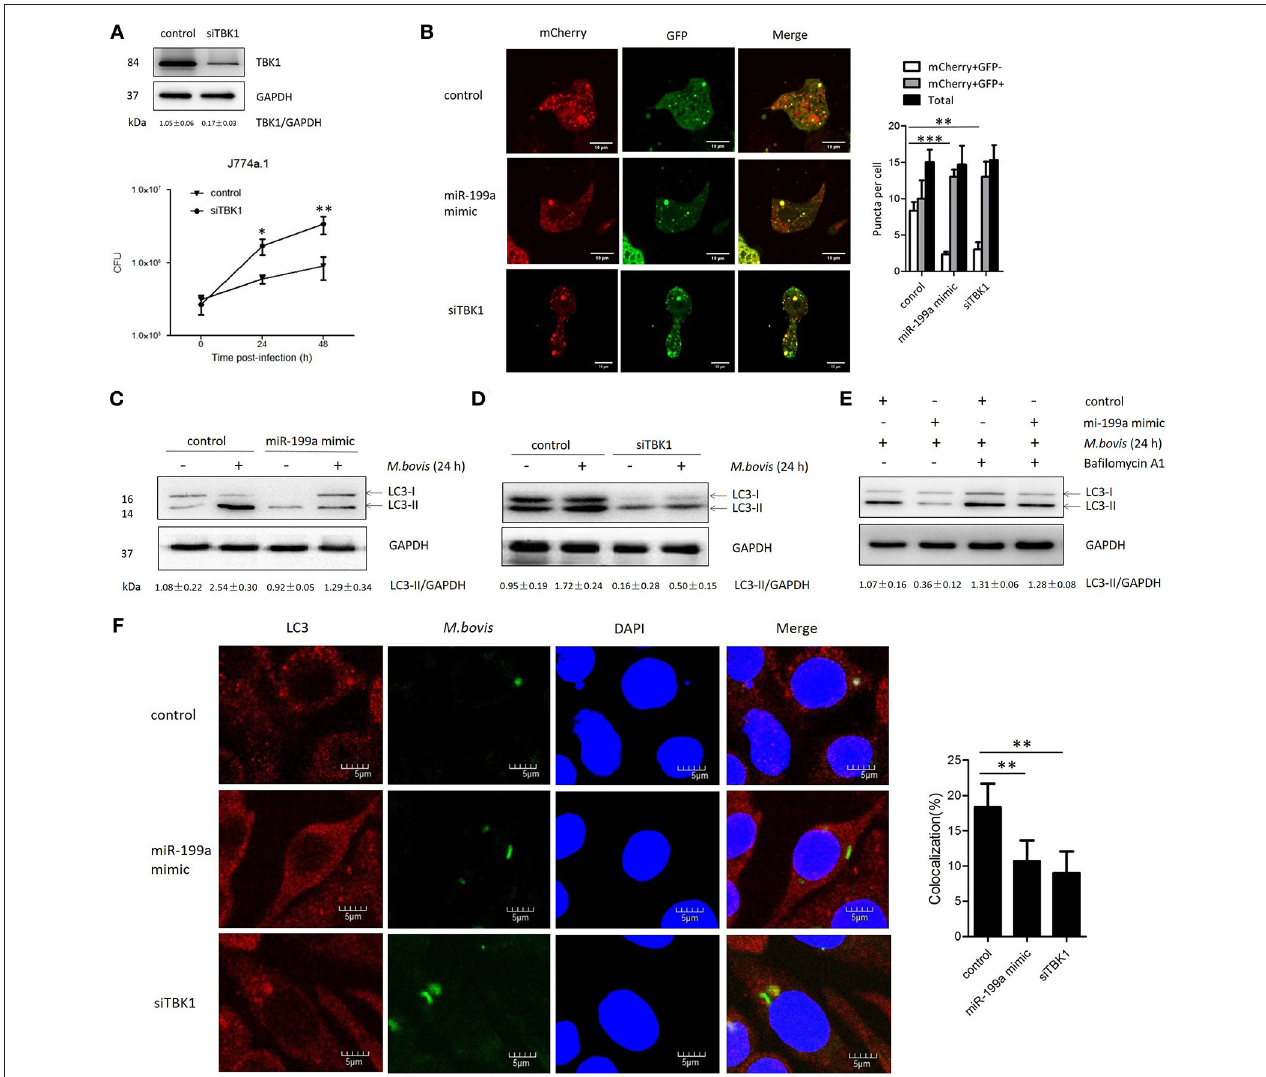
FIGURE 3 | miR-199a suppresses autophagosomes maturation by target TANK-binding kinase 1 (TBK1). (A) Interference efficiency of TBK1 by small interference RNA (siTBK1). Universal scrambled RNA was used as a control for siTBK1 or miR-199a mimic. TBK1 protein level was analyzed using western blotting in J774a.1 cells transfected with control or siTBK1. J774a.1 cells were pretreated with control or siTBK1 and infected with Mycobacterium bovis ( M. bovis ). M. bovis survival was analyzed by colony-forming units (CFU). (B) J774a.1 cells expressing were infected with Ad-mCherry-GFP-LC3 for 24h, then treated with control, miR-199a or siTBK1 for another 24h and then infected with M. bovis at a MOI of 10 for 24h. mCherry + GFP + , early autophagic organelles; mCherry + GFP − , late autophagic organelles. Images indicate merged green and red channels. 20 cells per group were counted for the relative fluorescence intensity. Image J software was used for the analysis. (C,D) Effect of miR-199a on LC3-II protein levels and degradation during autophagy. J774a.1 cells were pretreated with miR-199a mimic or siTBK1 for 24h and then infected with M. bovis at a MOI of 10 for 24h or left uninfected. The LC3-II /GAPDH ratios are shown below the blots. (E) Effect of miR-199a on LC3-II protein levels in the presence or absence of 100nM bafilomycin A1 (24h). Samples were then infected with M. bovis or left uninfected. The LC3-II /GAPDH ratios are shown below the blots. (F) Immunofluorescence staining of LC3 (red) of J774a.1 cells infected with Alexa 488-labeled M. bovis (green) at a MOI of 10 for 24h (left). The proportion of LC3-positive mycobacteria is shown (right). Cell nuclei were dyed with DAPI (blue). One hundred cells were used to calculate the colocalization proportion. Image J software was used for the analysis. Data is presented as mean ± SD in three independent experiments (* P < 0.05; ** P < 0.01; *** P < 0.001).